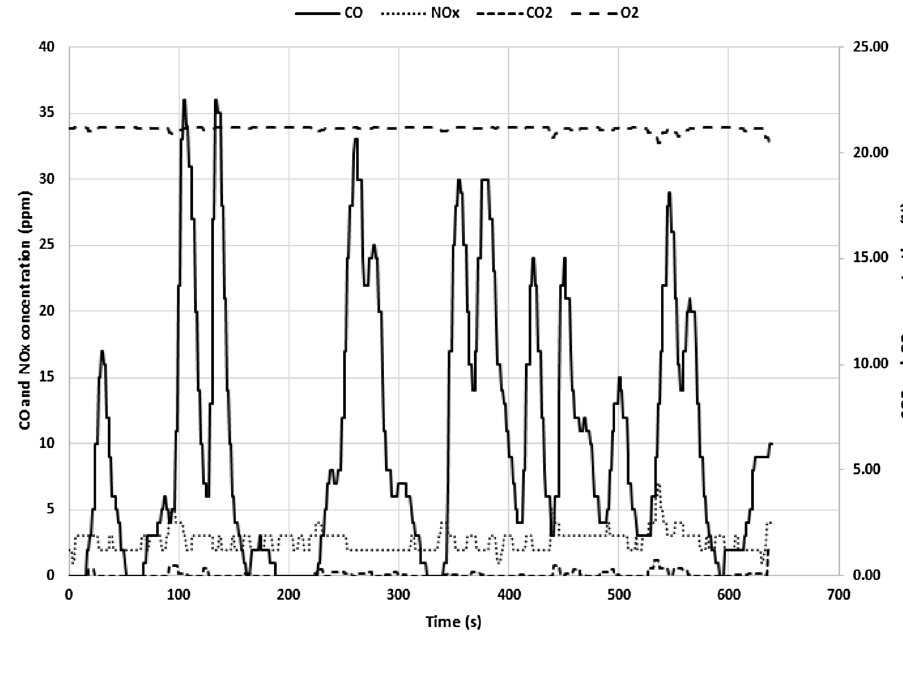
Fig. 9 Gases concentrations measured 50 cm above the plate: CO (solid line, ppm), NOx (dotted line, ppm), CO hyphened line, %) and O (large hyphened line,